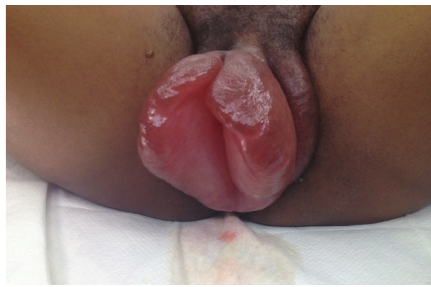
Figure 1: Massive edema of the labia minora prior to incisions and